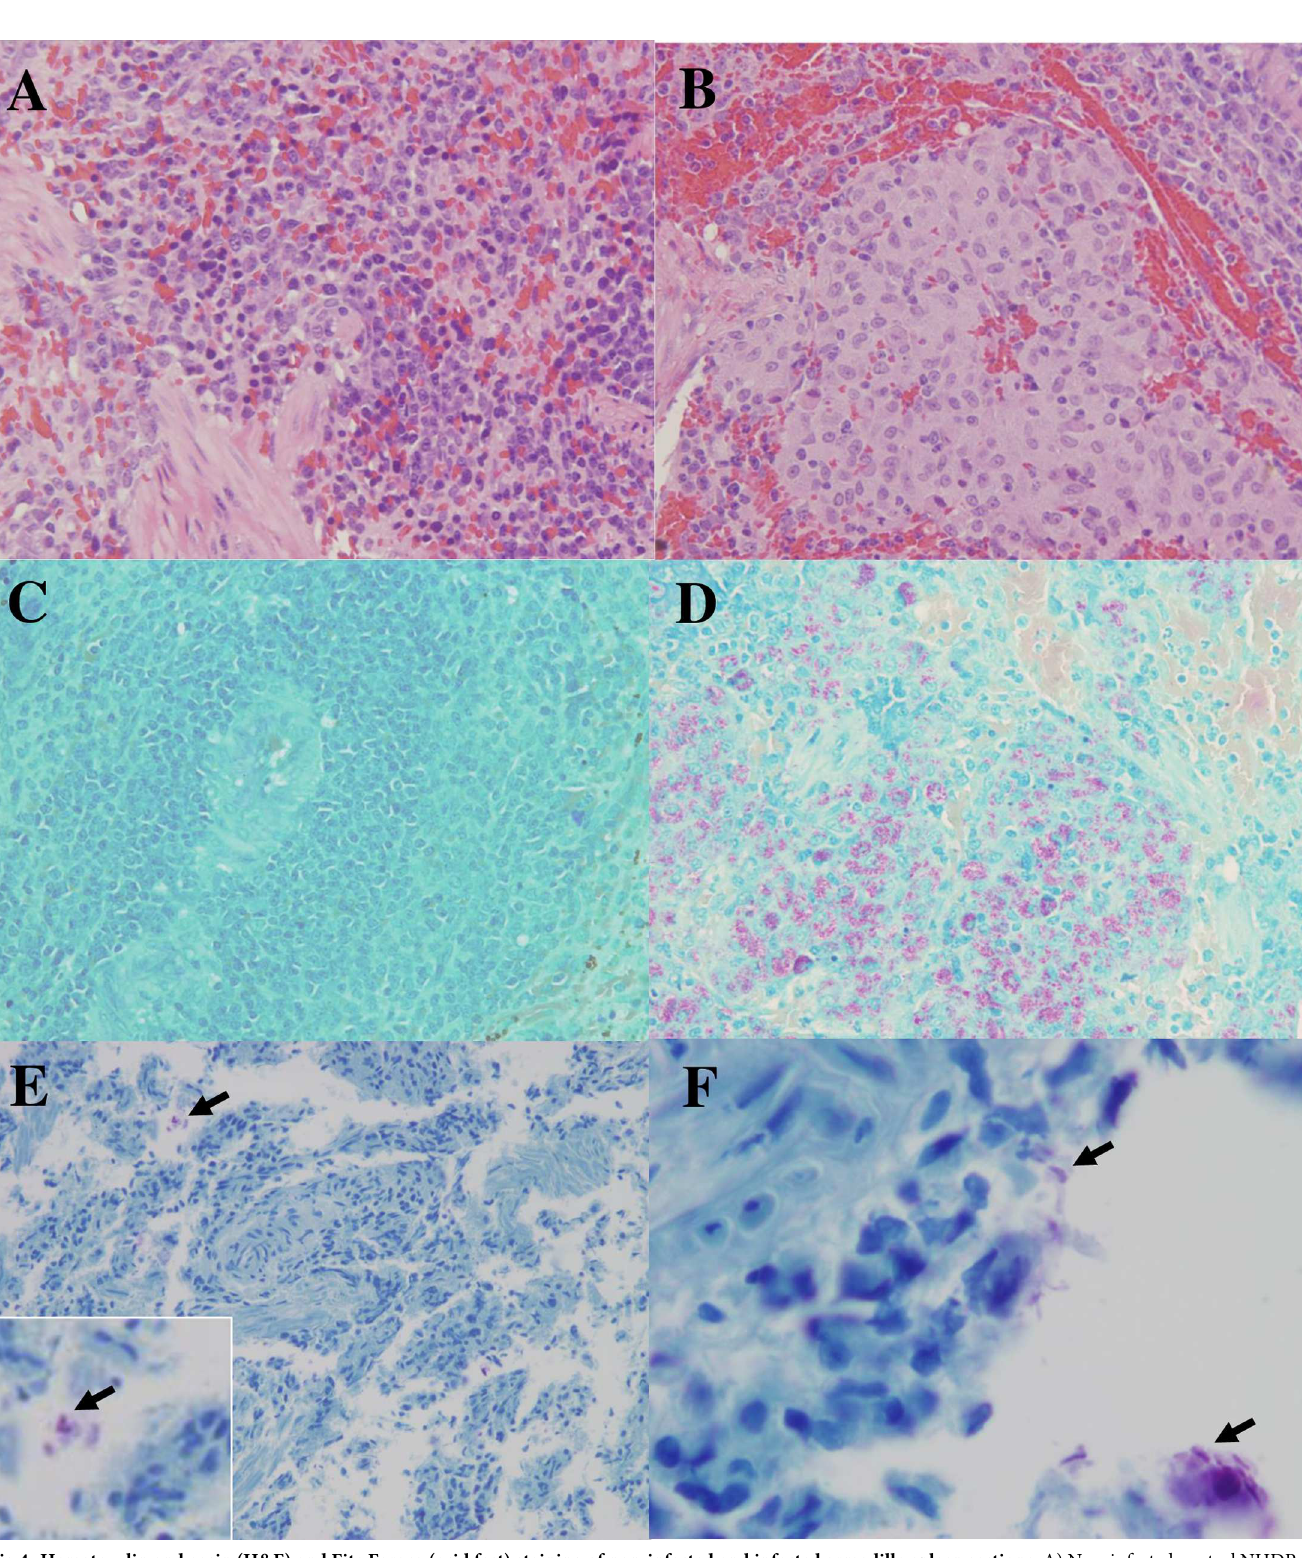
Fig 4. Hematoxylin and eosin (H&E) and Fite Faraco (acid fast) staining of non-infected and infected armadillo spleen sections. A) Non-infected control NHDP armadillo spleen (13–02) stained by H&E to show normal splenic architecture; B) M . leprae infected NHDP armadillo spleen (11I302) stained by H&E; C) Non-infected control NHDP armadillo spleen (12–70) stained by Fite Faraco method showing only counterstain; D) Many acid fast bacilli (red clusters) in M . leprae infected